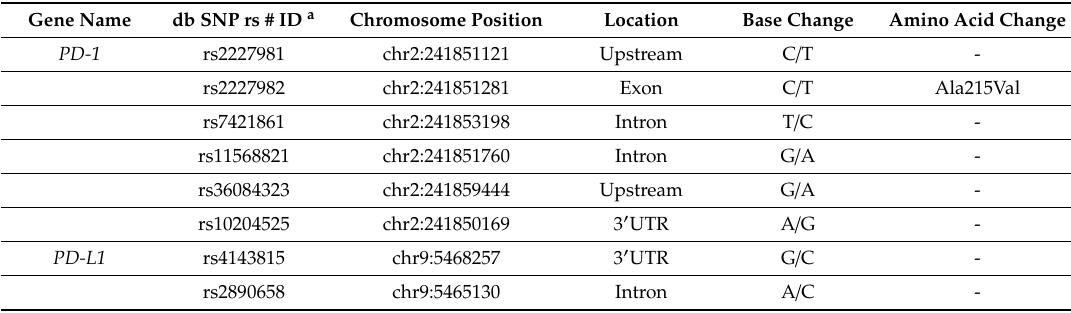
Table 1. Locations and base pair positions of single nucleotide polymorphisms (SNPs) in PD-1 and PD-L1